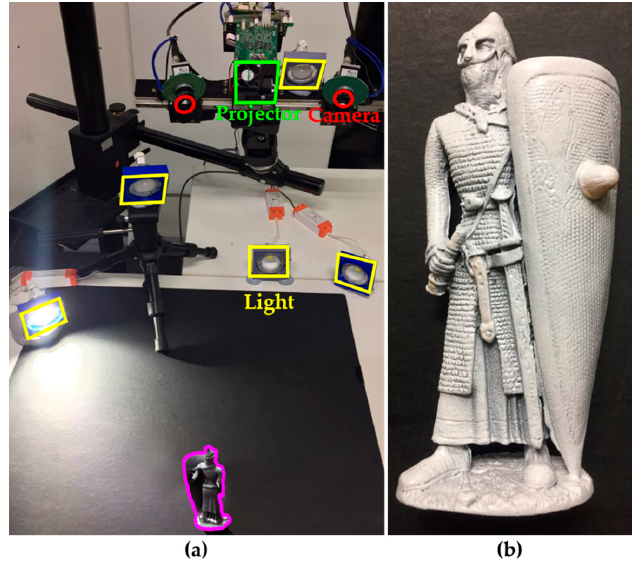
Figure 7. ( a ) Experiment environment; ( b ) Target object.